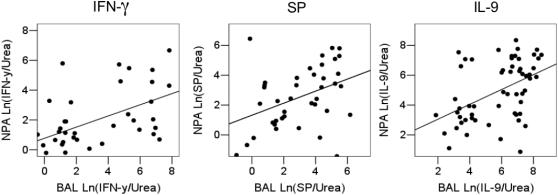
Scatter plot and best fit line between IFN-γ, SP and IL-9 concentrations (expressed Ln([cytokine]/[urea]), ng/mol) in paired samples of NPA and BAL.Pearson correlation coefficient: SP = 0.39 (n = 40, p = 0.01), IFN-γ = 0.35 (n = 38, p = 0.03)&IL-9 = 0.46 (n = 53, p = 0.001).